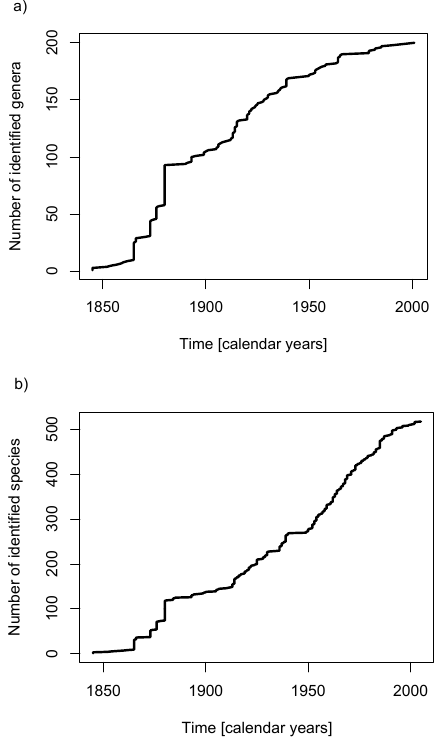
Figure 1. a) Genus accumulation curve with time for all currently known free-living nematodes in Hungary (200 genera). Data are not based on the legal status of genera (time of first official description), but on the real discovery of a new (even not yet recognized) genus. b)